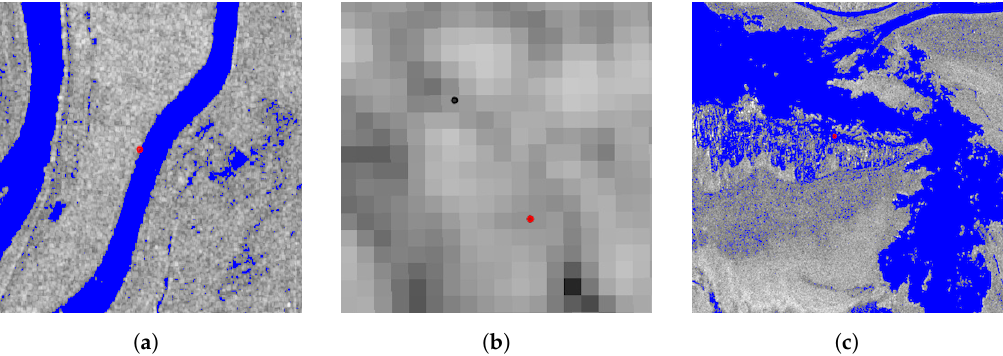
Figure 2. Three Situations of Misclassification: ( a ) A pixel (116.4064 E, 28.8405 N) that was misclassified into nonwater. ( b ) Two pixels with equal dB values but different truth label y (116.2196 E, 28.9905 N) (116.2201 E, 28.9899 N). ( c ) A pixel (116.1584 E, 29.2136 N) that was misclassified into water.